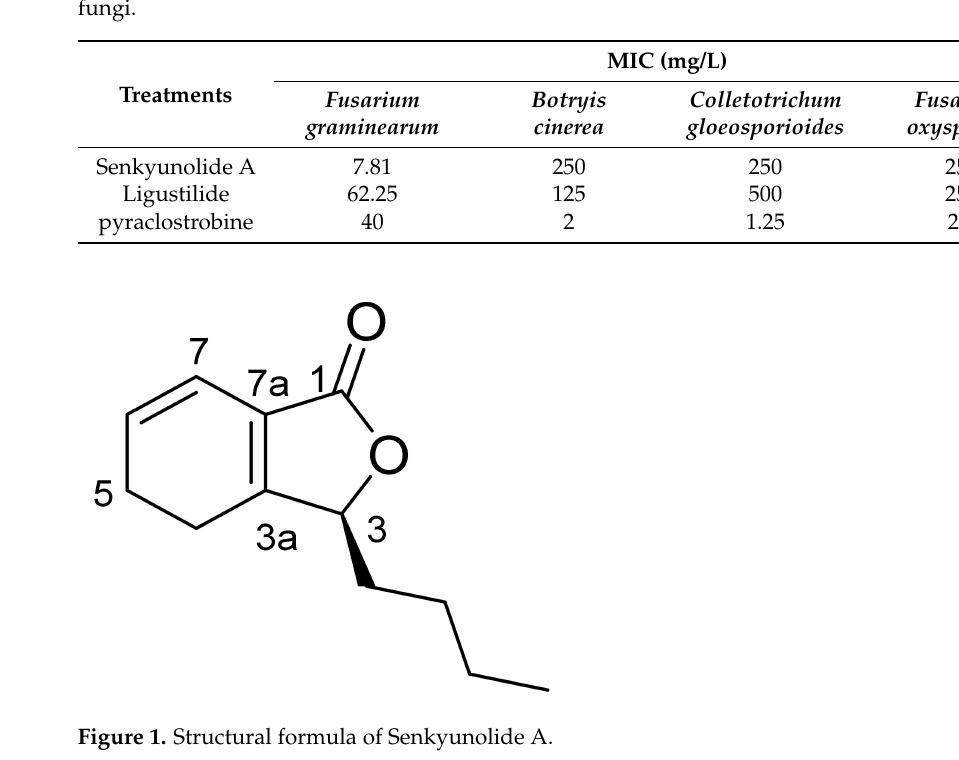
Table 8. Determination results of the MIC of compounds CQ2 and CQ4 against the four pathogenic